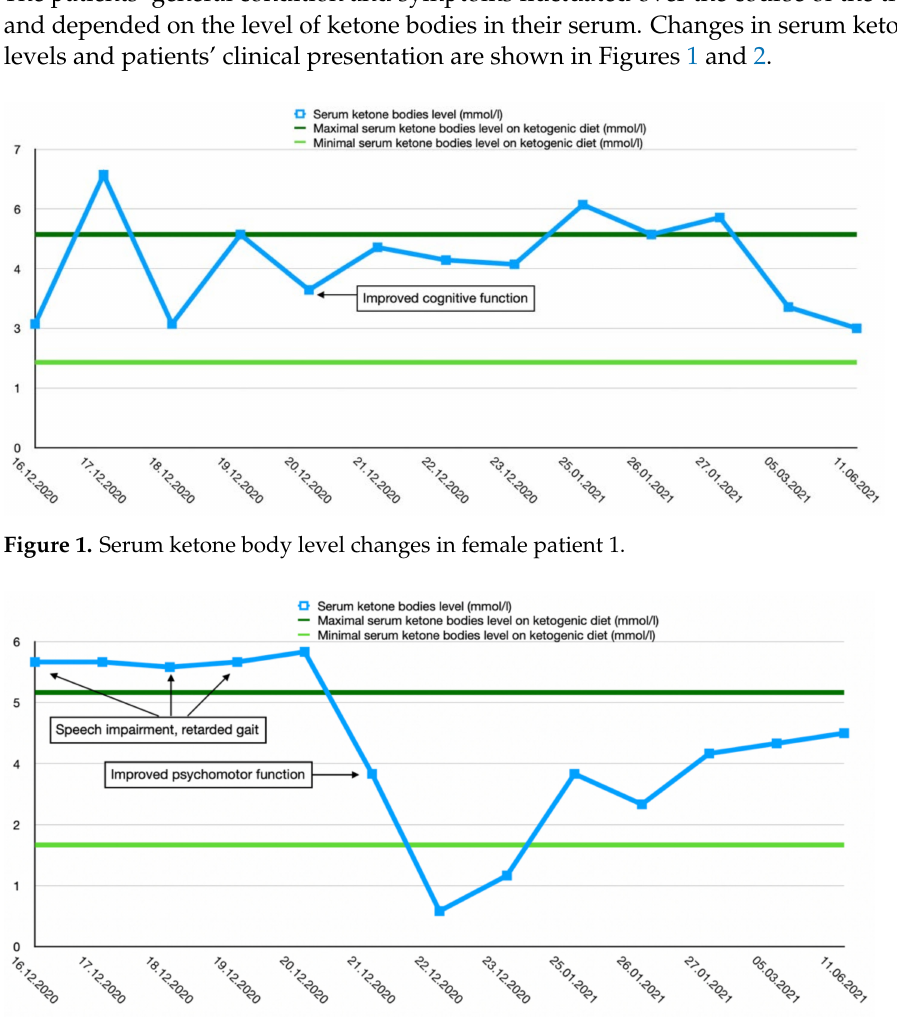
Figure 2. Serum ketone body level changes in male patient